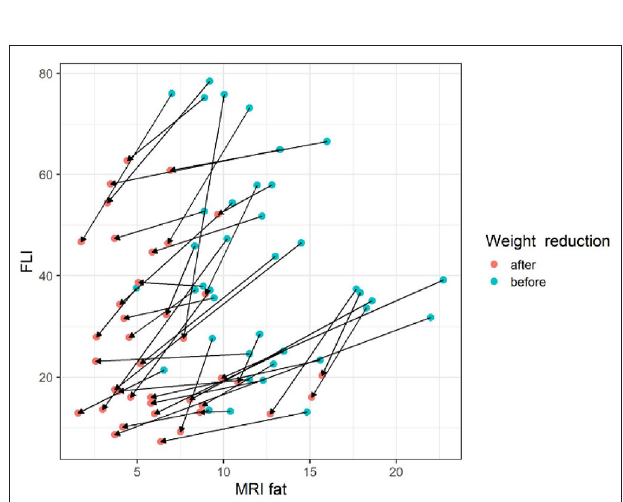
FIGURE 4 | The changes of FLI according to MRI fat before and after body weight reduction. The slope of each line appears in various ways without a particular pattern. Since the amount of change in the FLI value according to the amount of change in the MRS fat fraction is not constant, it appears that the FLI cannot consistently reflect the MRS fat fraction. MRS, magnetic resonance spectroscopy; FLI, fatty liver index. Blue circle, before weight reduction; red circle and arrows, after weight